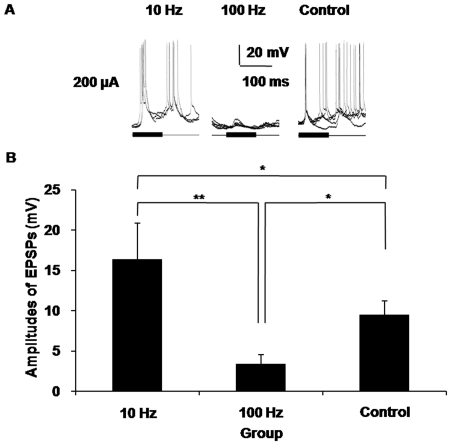
Electrical stimuli in the MGBv modulated the auditory responses of AI neurons.A) High- and low-frequency train electrical stimulation in the MGBv induced different effects in the auditory responses of AI neurons. The amplitudes of the sound-evoked EPSPs increased when the frequency of the train stimuli was 10 Hz and the electric current strength was 200 µA. In contrast, the 100 Hz train electrical stimulation of the MGBv with the same current strength depressed the sound-evoked responses of AI neurons. B) The statistical histogram of the average amplitudes of the EPSPs induced by sound after electric stimulation of the MGBv. The data were from the same recordings as in (A). The amplitudes of the noise-evoked EPSPs from the 10 Hz group were higher than those of both the 100 Hz group and the control group. The amplitudes in the 100 Hz group were also lower than those in the control group. (*P<0.05, **P<0.01, Error bars, S.D.).